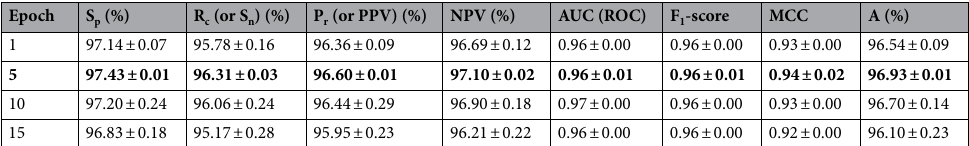
Table 18. Proposed MGMT-PMP system results cross-validated 10-folds with epochs variation for dynamic feature extraction depicting analysis based on performance with RA, using 1-NN classifier for BraTS-2021 dataset. Significant values are given in